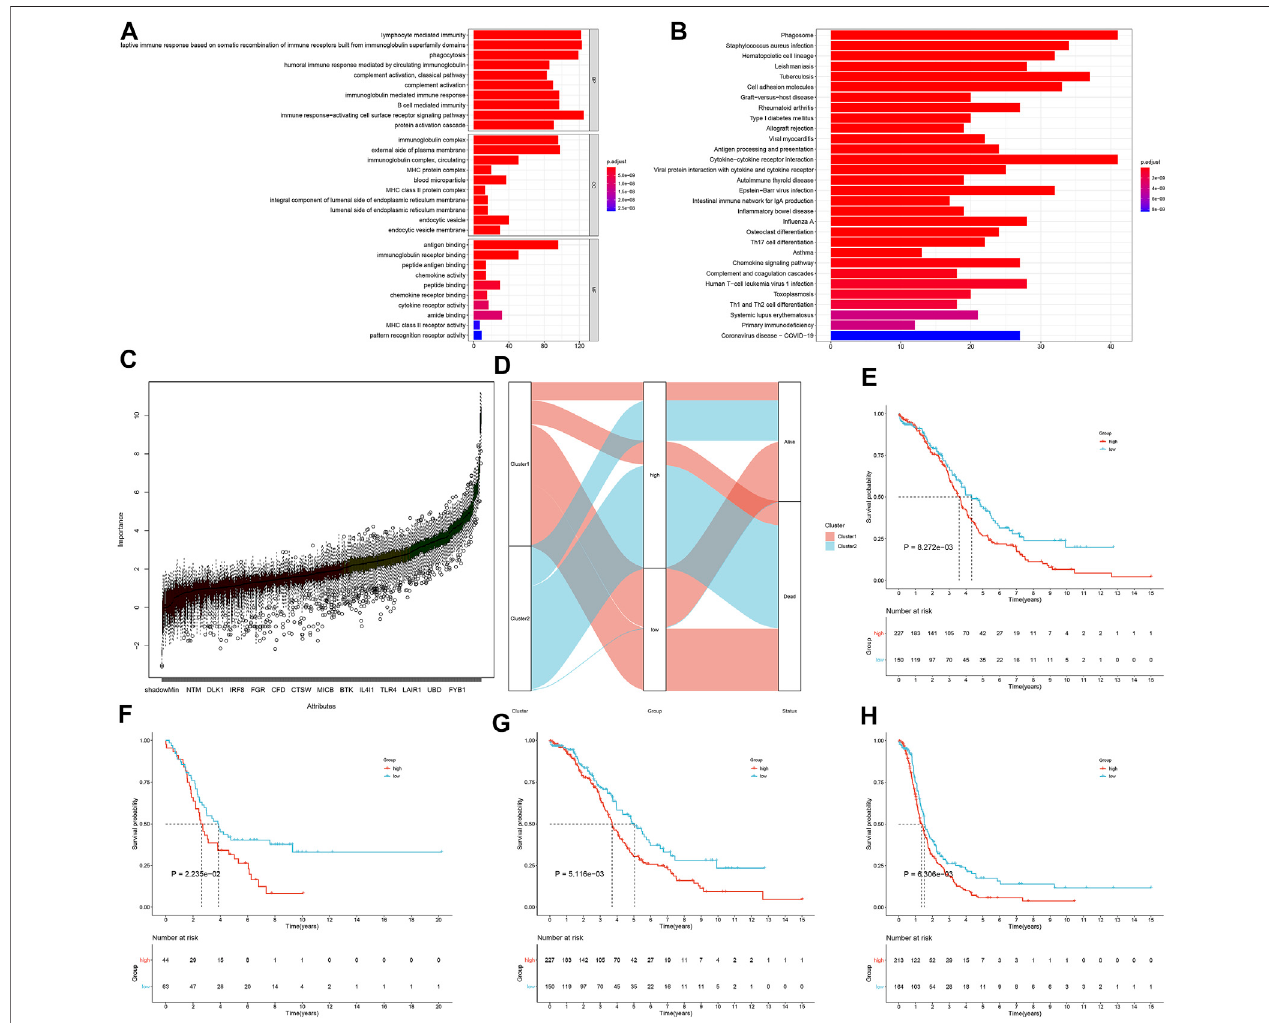
FIGURE 4 | Development of an immune scoring system for OC. (A) GO enrichment results of immune subtype – derived genes. (B) KEGG pathway enrichment results of immune subtype – derived genes. (C) Identi fi cation of characteristic immune subtype – derived genes with Boruta feature importance analyses. (D) Alluvial diagram depicting the connections of immune subtypes, immune score, and survival status. (E) Kaplan – Meier analyses for the OS discrepancy in OC patients with high and low immune score in TCGA cohort. (F) Veri fi cation of the OS difference between high and low immune score patients in the GSE26193 dataset. (G,H) Kaplan – Meier analyses for the DSS and PFI difference in OC patients with high or low immune score in TCGA cohort.